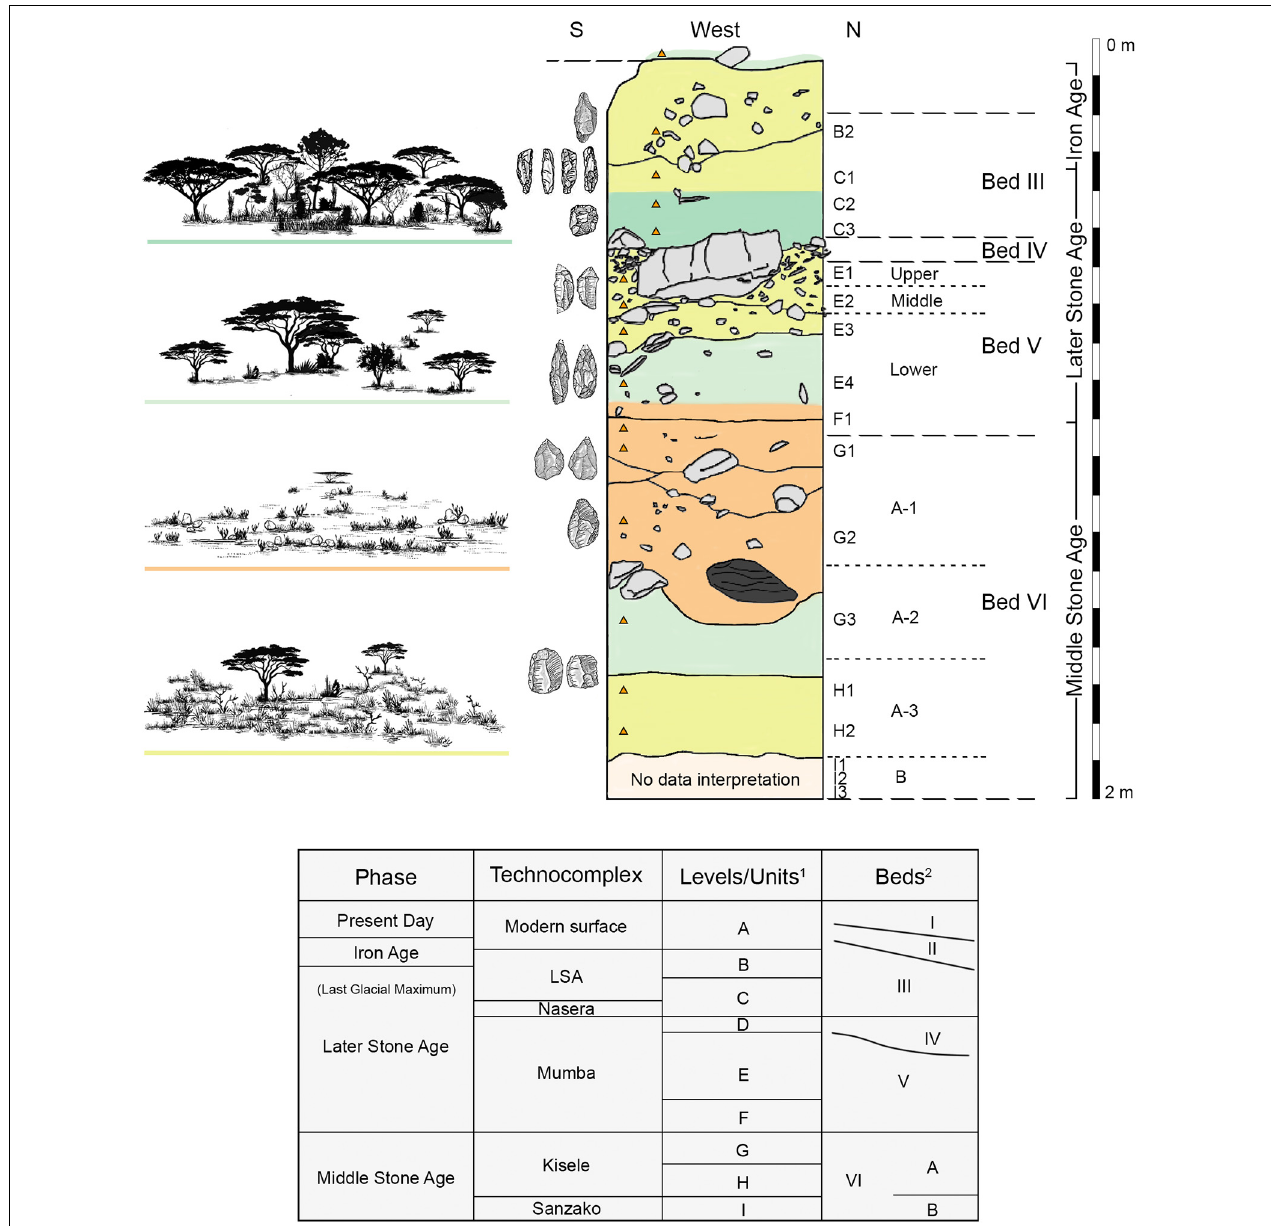
FIGURE 4 | (Upper Box) Center: Trench 9 showing sample location (orange triangle). Letters designate geological units, while numerals refer to sample number within the unit. Mehlman’s 1989 nomenclature for Mumba’s sedimentary beds (right) are listed as well as the culture history affiliation throughout the stratigraphy with selected examples of excavated stone tools per phase. Left: Artist rendering of general vegetation physiognomy informed by phytolith analysis. (Lower Box) Nomenclature equivalents modified from 1 Prendergast et al. (2007) and Luque (2014); 2 Mehlman